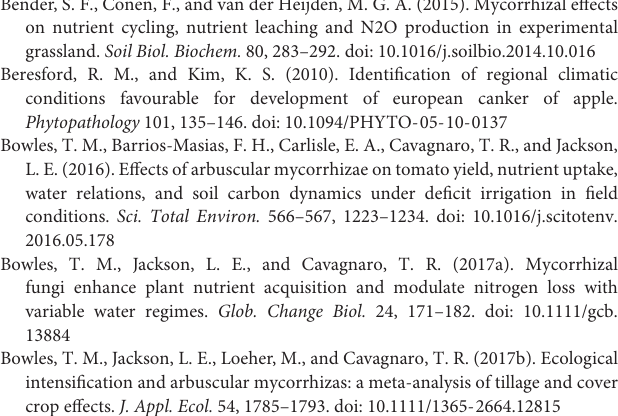
TABLE S1 | Apple tree macronutrient applications. TABLE S2 | Apple tree micronutrient applications. TABLE S3 | Treatment means and ± SE for parameters of apple ( Malus pumila ) performance per nutrient treatment (low or high) and scion type (Dabinett or Michelin), where significant interactions between nutrient treatment and scion type were reported by four-way ANOVA analysis. TABLE S4 | Treatment means and ± SE for parameters of apple ( Malus pumila ) performance per arbuscular mycorrhizal fungal (AMF) inoculation treatment (AMF inoculation or non-inoculation) and rootstock type (MM106 or MM111), where significant interactions between inoculation treatment and rootstock type were reported by four-way ANOVA analysis. TABLE S5 | Treatment means and ± SE for parameters of apple ( Malus pumila ) performance per scion (Dabinett or Michelin) and rootstock type (MM106 or MM111), where significant interactions between scion and rootstock type were reported by four-way ANOVA analysis. TABLE S6 | Treatment means and ± SE for parameters of apple ( Malus pumila ) performance per nutrient treatment (low or high) and rootstock type (MM106 or MM111), where significant interactions between nutrient treatment and rootstock type were reported by four-way ANOVA